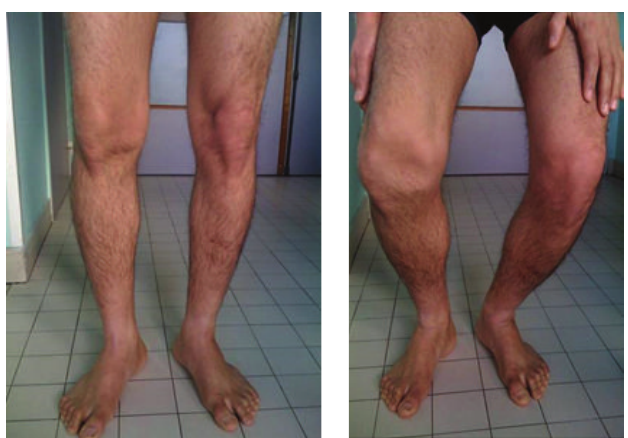
Figure 1: Preoperative assessment: the patella is in place in extension and dislocated in flexion.